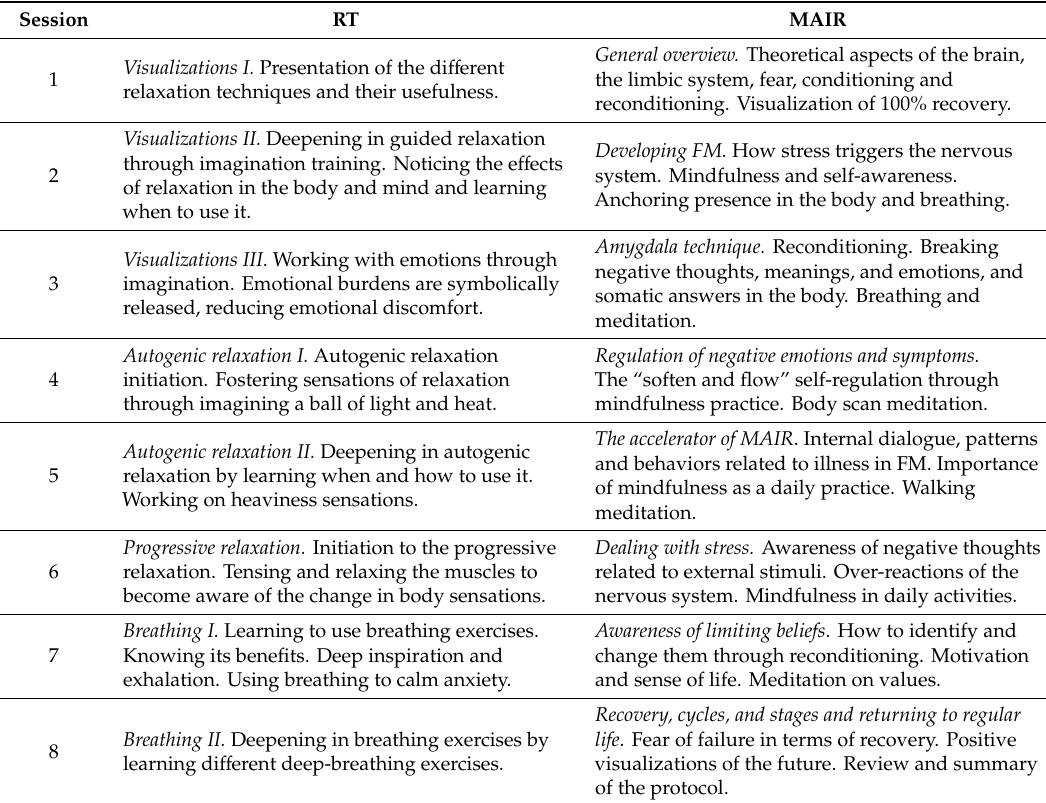
Table 1. Session outlines of the RT and